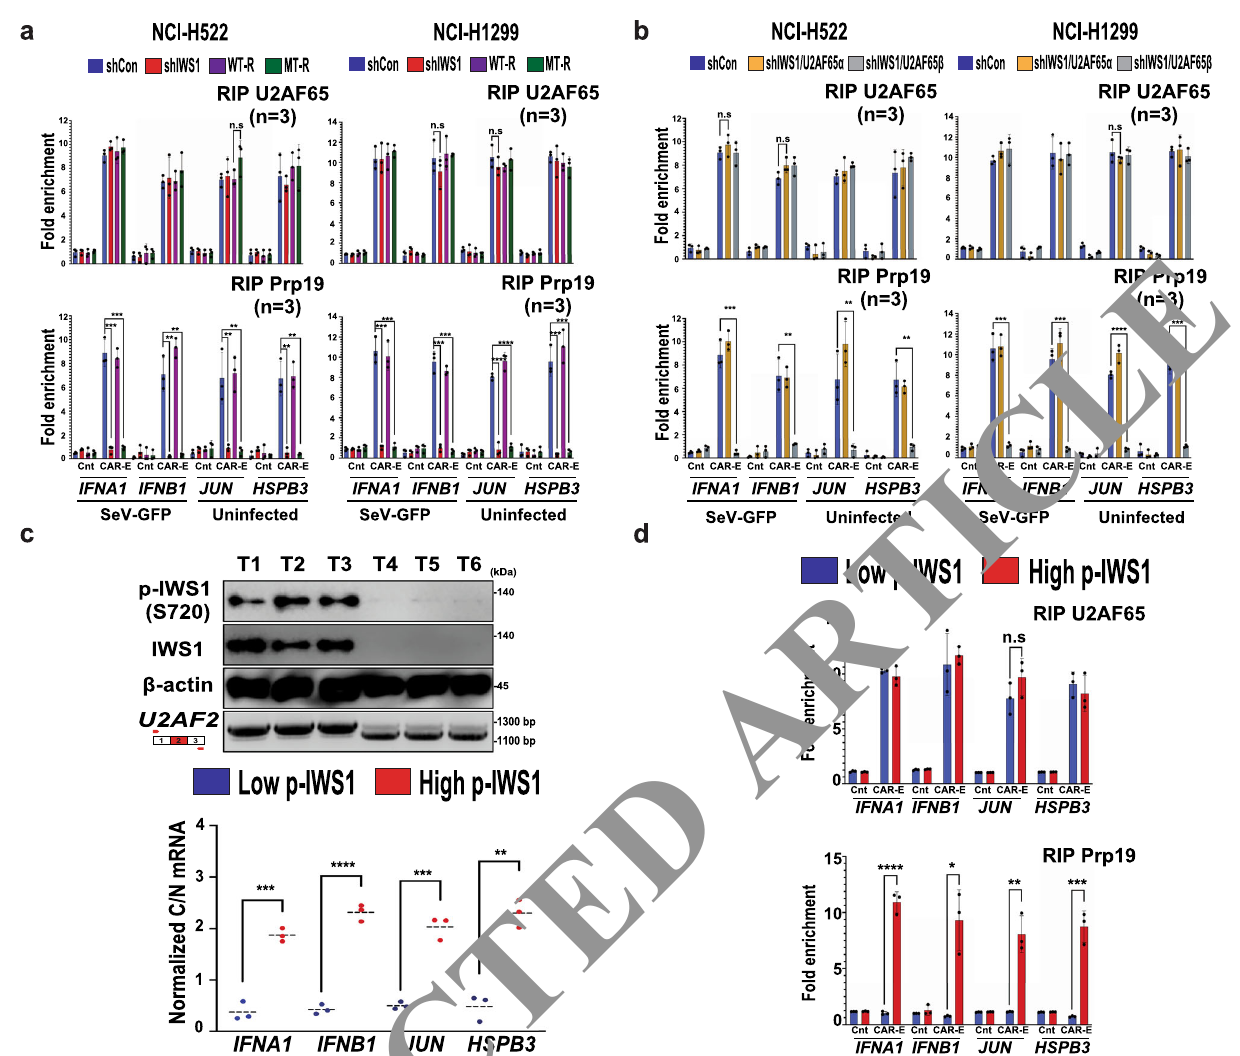
Fig. 3 IWS1 phosphorylation controls the recruitment of Prp19 to mRNA CAR-Elements, by promoting the inclusion of exon 2 in the U2AF2 mRNA, in both cultured cells and primary human LUADs. a , b . IWS1 phosphorylation controls the recruitment of Prp19 to CAR-Elements, by regulating U2AF2 alternative RNA splicing . NCI-H522 and NCI-H1299 cells transduced with the indicated constructs, were infected with SeV-GFP (MOI 0.5). 24 h later, infected cells and parallel cultures of uninfected cells, were used for RIP assays addressing the binding of U2AF65 (upper panels) and Prp19 (lower panels) to CAR- Elements or to sequences without CAR-Elements in the indicated RNAs. The bars show the mean fold enrichment in U2AF65 and Prp19 binding (anti- U2AF65 or anti-Prp19-IP, vs IgG control-IP) ± SD. Data were normalized relative to the input (2%). The map location of the PCR primers used to amplify the binding regions is shown in Supplementary Fig. 2a. c The IWS1 phosphorylation-dependent nuclear export of the mRNAs of intronless genes is active in human Lung Adenocarcinomas. ( Upper panel) Western blots of lysates of 6 human LUAD samples (3 with high and 3 with low IWS1 expression), randomly selected out of LUAD samples previously analyzed 3 , were probed with the indicated antibodies (top three rows). RT-PCR, using primers mapping in U2AF2 exons 1 and 3 (bottom row) (Lower Panel) LUAD tumor samples were fractionated into cytoplasmic and nuclear fractions. mRNA levels of the indicated genes were determined in each fraction, using qRT-PCR. Fractionation was validated as in Figs. 1b, c and 2b, e (Supplementary Table 4). Swarm plots show the individual Cytoplasmic/Nuclear RNA ratios, normalized to the 18S ribosomal RNA. They also show the mean C/N value ± SD. d IWS1 phosphorylation controls the recruitment of Prp19 to CAR-Elements in the mRNAs of CAR-Element-positive intronless genes, in human Lung Adenocarcinomas . RIP assays in the high and low-IWS1 LUADs, shown in c. The bars show the mean fold enrichment in U2AF65 (upper panel) and Prp19 (lower panel) binding to the same CAR- Element-positive and CAR-Element-negative regions as in ( a ) and ( b ) (anti-U2AF65 or anti-Prp19-IP, vs IgG control-IP) ± SD. Data were normalized relative to the input (2%). All experiment in this fi gure were done in triplicate, on three biological replicates. n.s: non-signi fi cant * p < 0.05, ** p < 0.01, *** p < 0.001, **** p < 0.0001 (one-side unpaired The RNA Pol II promoter of type I IFN genes, plays an essential role in the IWS1 phosphorylation-dependent mRNA nuclear export . Earlier studies had shown that U2AF65 binds RNA Pol II and recruits Prp19. During transcriptional elongation, both U2AF65 and Prp19 are loaded to the newly synthesized pre- mRNA, promoting RNA splicing co-transcriptionally 26 . This suggested that U2AF65 and Prp19 might be loaded to the CAR-